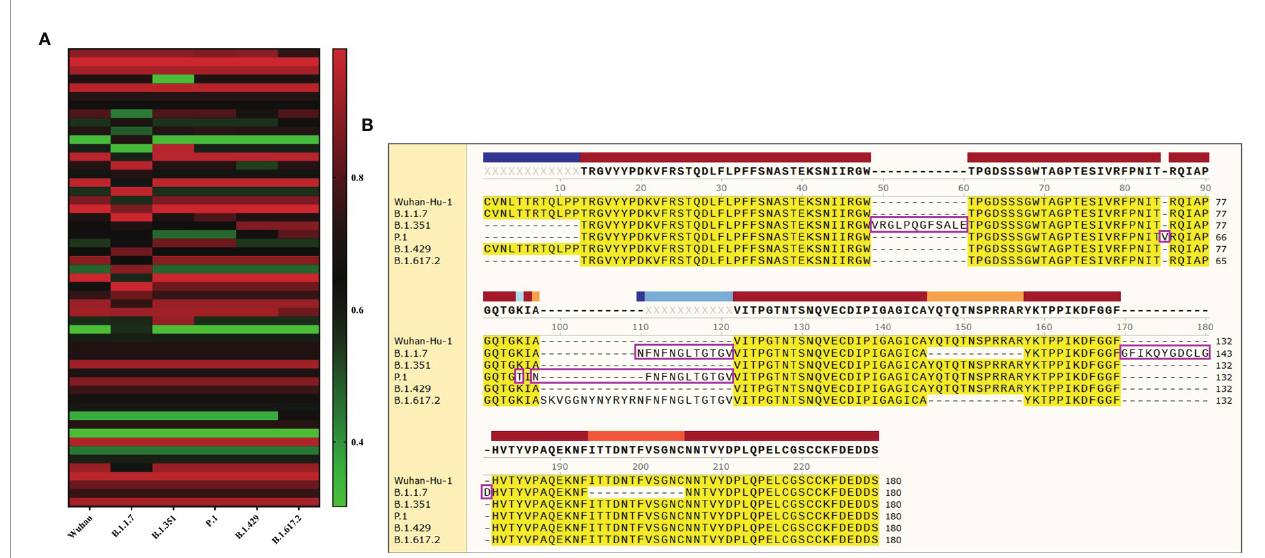
FIGURE 6 | The identi fi cation of B-cell epitopes. (A) All the LBEs of the S protein in the 6 SARS-CoV-2 strains were shown here. The abscissa represents the six virus strains and the ordinate represents the Rank of the epitope peptide. (B) All epitopes of each virus strain were connected in sequence according to the size of the starting position, and the epitopes that had undergone mutation were in the “ pink ” box. Through sequence alignment, all the common and variant epitopes of all strains were used for vaccine